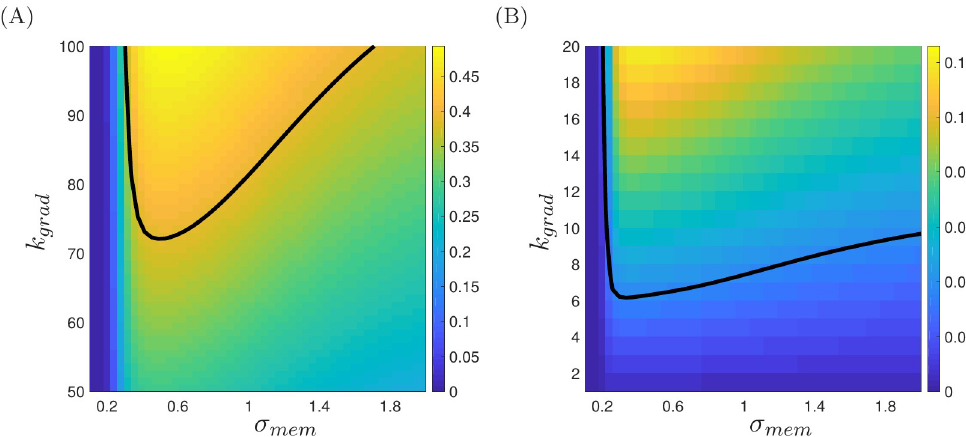
Fig 6. Plots of the mean chemotactic index attained for each combination of k model against the healthy control data of [10] using a mean cell velocity of 3.77 μ m/min; the black line represents a mean chemotactic index of 0.39. In (B), we calibrate our model against the COPD-affected data of [10] using a mean cell velocity of 0.09 μ m/min; the black line represents a mean chemotactic index of